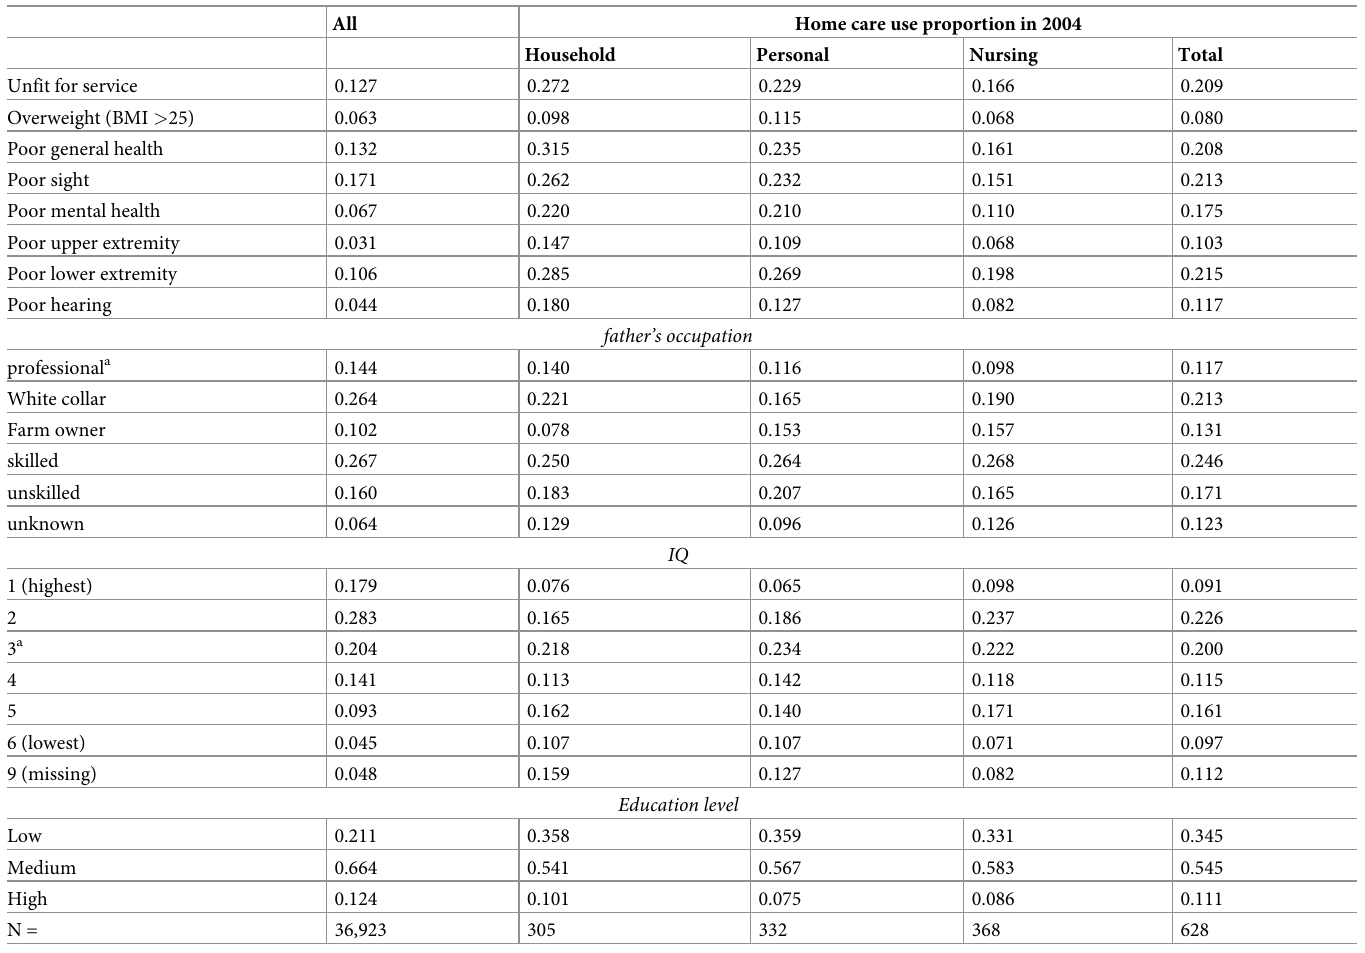
Table 1. Descriptive statistics–conditions at age